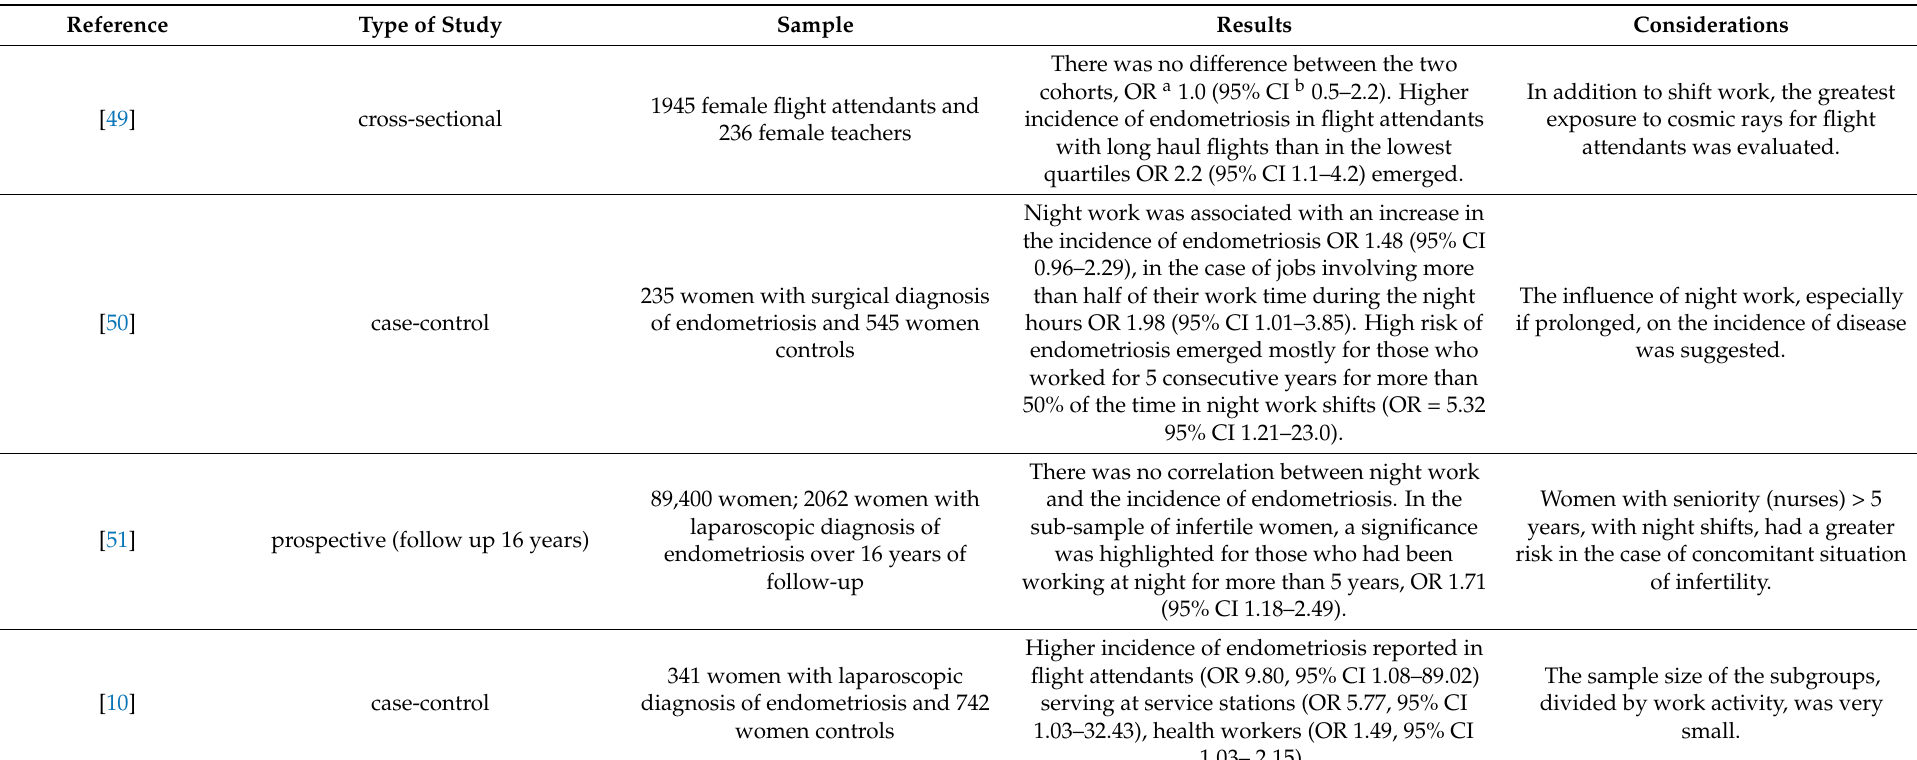
Table 4. Description of investigations conducted with respect to night/shift work and